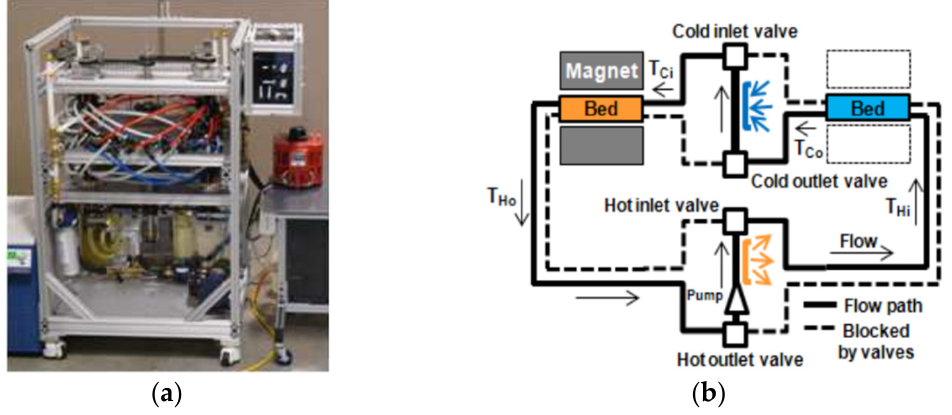
Figure 8. Device ( a ) and operating schematic ( b ) of Jacob et al. [49].